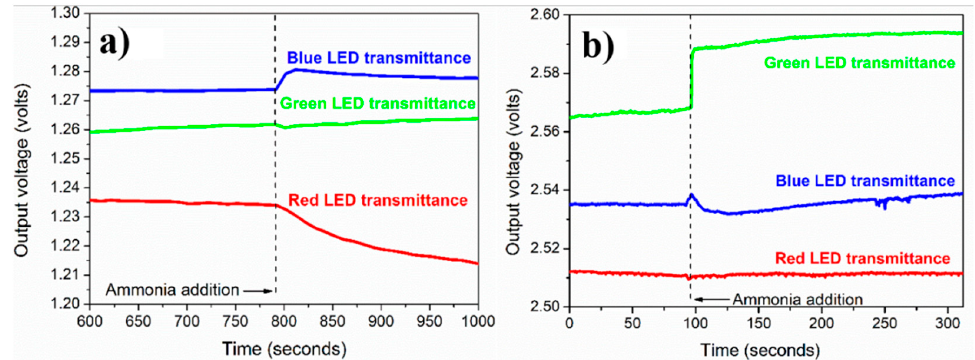
Figure 6. Variation of POF output voltage with time for PVP capped Ag-NPs synthesized by using ( a ) cold and ( b ) polyol synthesis methods (ammonium solution concentration = 2 M).